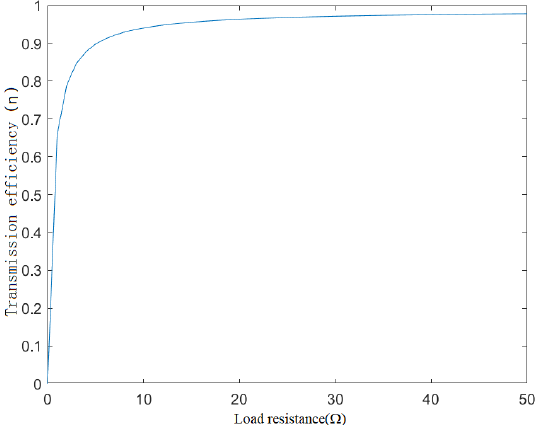
Figure 7. Relationship between transmission efficiency and load resistance under the two coils.